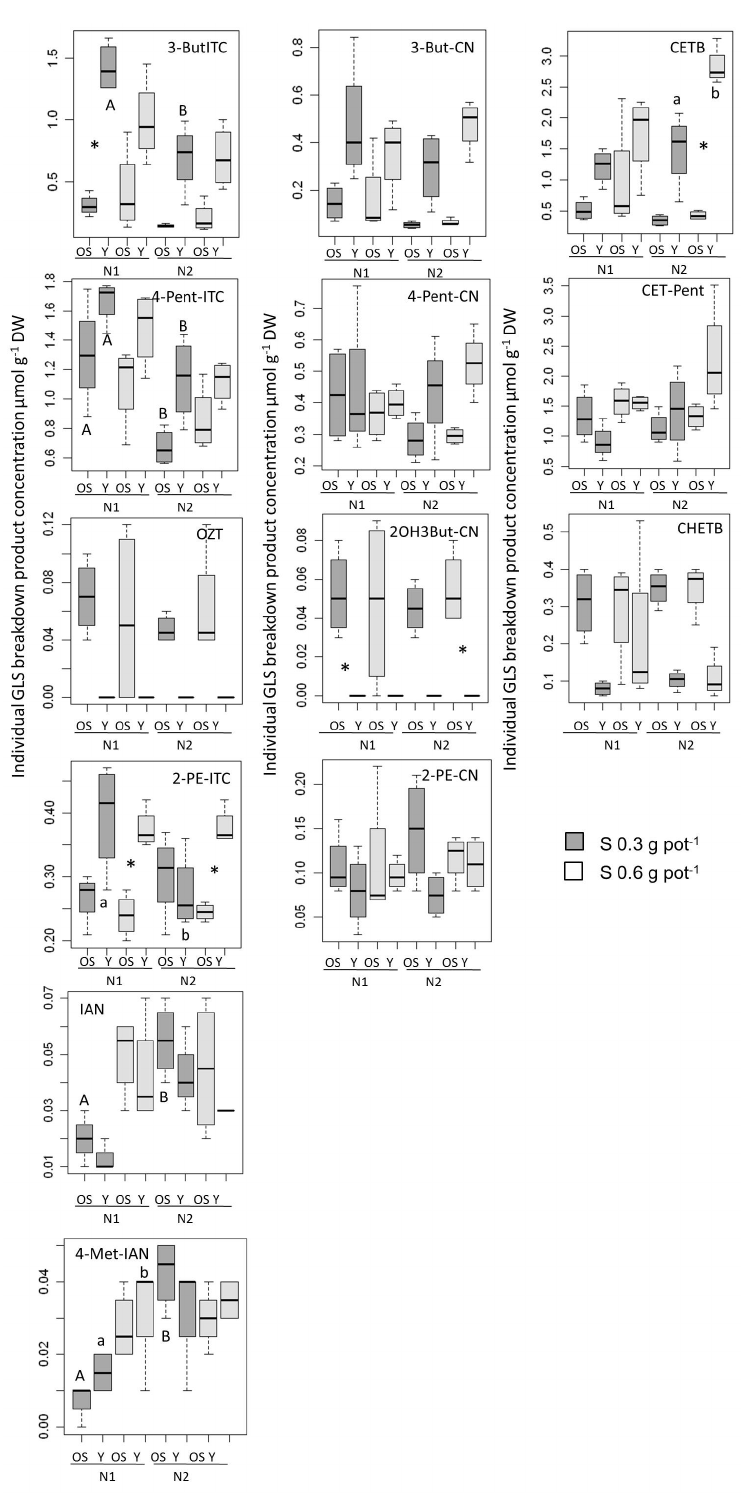
Fig. 5: Different GLS breakdown products extracted from the cvs. Orient Surprise (OS) and Yuki (Y) in dependency to the N (1.0 and 2.0 g pot -1 ) and S (0.3 and 0.6 g pot -1 ) supply. N1, 1 g pot -1 ; N2, 2 g pot -1 . Abbreviations: 3But-ITC: 3-butenyl-ITC, 3But-CN: 4-pentenenitrile, CETB: 1-cyano-3,4- epithiobutane, 4Pent-ITC: 4-pentenyl-ITC, 4Pent-CN: 5-hexenenitrile, CETPent: 1-cyano-4,5-epithiopentane, OZT: 5-vinyl-1,3-oxazolidine-2- thione, 2OH3But-CN: 3-hydroxypentenenitrile, CHETB: 3-hydroxy-4,5-epithiopentylnitrile, 2PE-ITC: 2-phenylethyl ITC, 2PE-CN: 3-phenylpro- panenitrile, IAN: indolacetonitrile, 4Met-IAN: 4-Methoxyindole-3-acetonitrile. Uppercase letters represent significant differences between the N treatments, lower case letters represent significant differences between S treatments and asterisks indicate significant differences between B. rapa cvs. Orient Surprise (OS) and Yuki (Y). The compounds are grouped according to intact GLS precursors. 3But-ITC, 3But-CN and CETB are de- rived from 3Butenyl GLS; 4Pent-ITC, 4Pent-CN and CETPent are derived from 4Pentenyl GLS; OZT, 2OH3But-CN and CHETB are derived from 2( R )-2OH3Butenyl GLS; 2PE-ITC and 2PE-CN are derived from 2Phenylethyl GLS; IAN is derived from 3Indolylmethyl GLS and 4-Met-IAN is derived from 4Methoxy-3-indolylmethyl